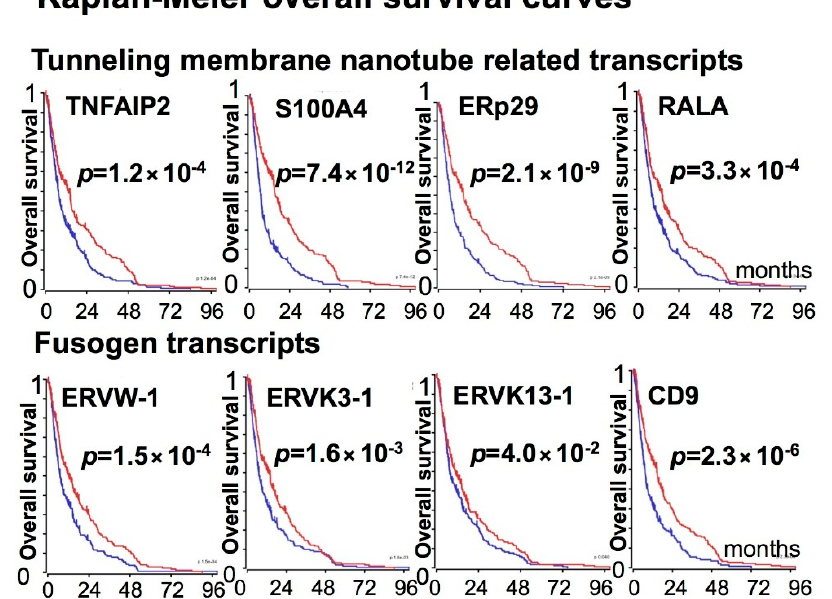
Figure 2. Expression of the tunneling membrane nanotube-related transcripts (TNFAIP2, S100A4, ERp29, RALA) and the fusogen transcripts (ERVW-1, ERVK3-1, ERVK13-1, CD9) significantly decreased overall survival of glioma patients. Graphs illustrate the Kaplan–Meier overall survival curves for patients with gliomas harboring low (red) or high (blue) expression of the corresponding transcripts (Rembrandt, Madhavan, Mas 5.0-U132p2 study from R2: platform, median cut-off modus). For all illustrated transcripts, the differences were significant, p < 0.05.